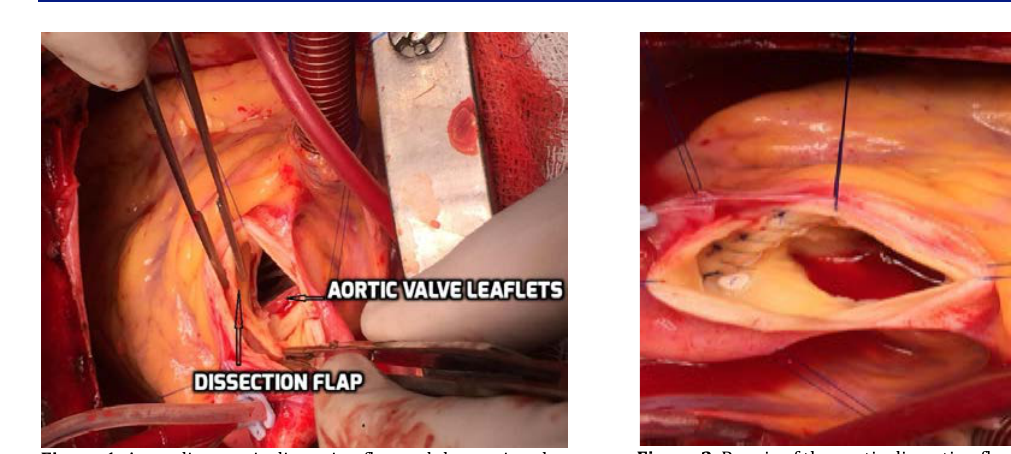
Figure 1. Ascending aortic dissection flap and the aortic valve